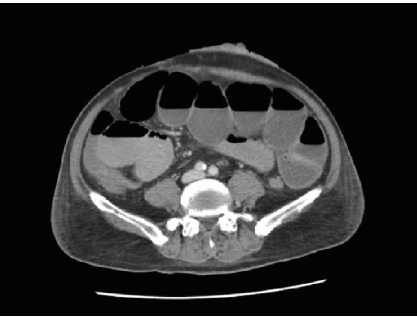
Figure 4: CT of the abdomen showing the small bowel obstruction with transition zone at the proximal